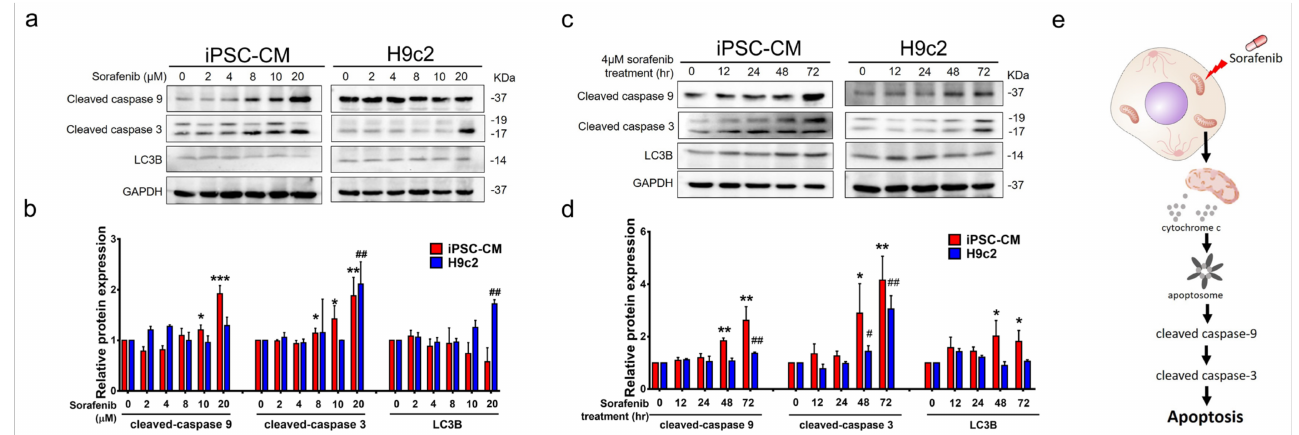
Figure 6. Apoptosis markers of cleaved caspase 9, cleaved caspase 3, and autophagy marker LC3B expressed in hiPSC − CMs and H9c2 cells dose- and time-dependently. ( a ) hiPSC − CMs and H9c2 cells treated with sorafenib under 2, 4, 8, 10, and 20 µ M for 72 h. Apoptosis markers (cleaved caspase 9, cleaved caspase 3) and autophagy marker (LC3B) were analyzed by Western blot. ( b ) Quantification of cleaved caspase 9, cleaved caspase 3, and LC3B expression from diagram a. p -values, * p < 0.05,